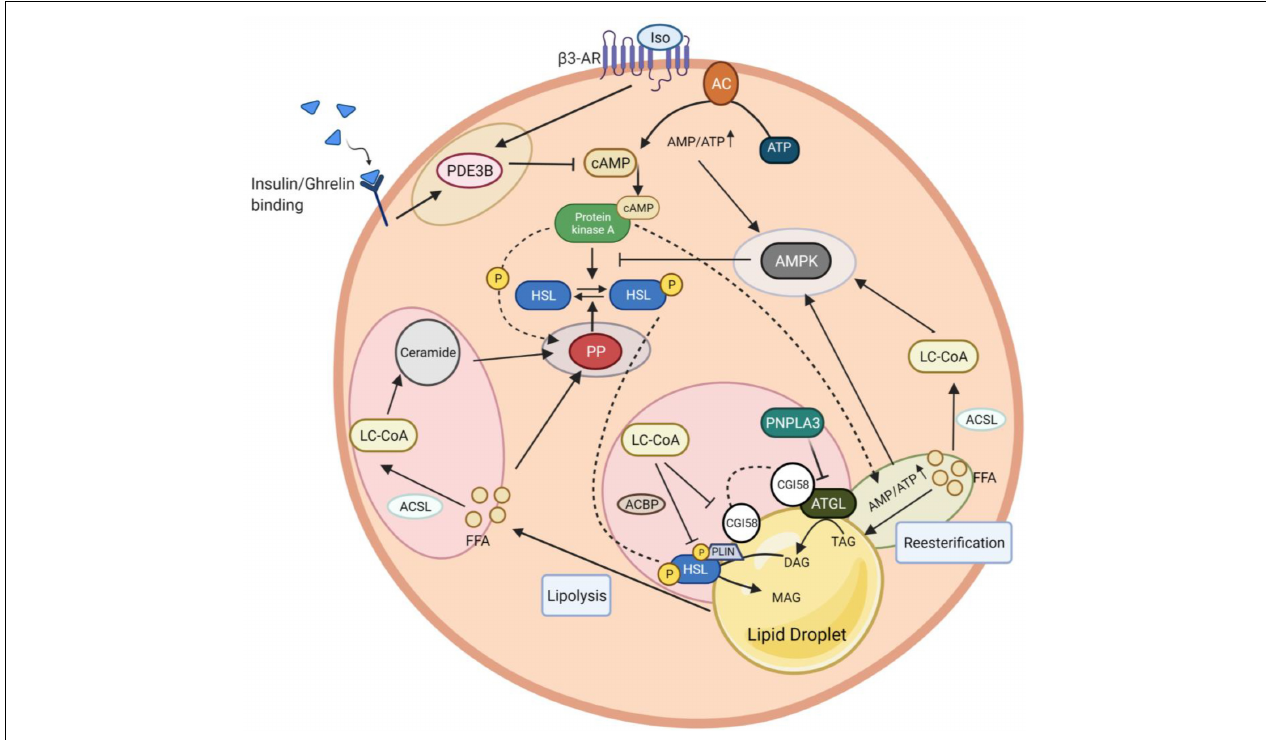
FIGURE 3 | Intracellular networks regulate adipocyte lipolysis brake. The figure illustrates five feedback mechanism loops of lipolysis marked with different colors. Insulin and isoproterenol regulate lipolysis inhibition through PDE3B-mediated cAMP degradation (yellow circle). The fine-tuning of cAMP activation involves AMPK to induce a negative feedback loop in lipolysis. AMPK stimulation is coordinated via interaction with LC-CoA, which results from ACSL-mediated FFA conversion (light blue circle). Besides LC-CoA, cAMP production and degradation together with re-esterification, participate in this AMPK induction due to an increase of the AMP/ATP ratio yielded during these processes. PKA can potentially activate a re-eseterification enzyme called DGAT (green circle). Elevated AMPK promotes a negative feedback loop of lipolysis by inhibiting PKA-mediated HSL phosphorylation. In contrast to PKA, HSL phosphorylation can be reversed by PP, whose activation highly relies on the presence of FFA and PKA to induce a feedback mechanism (purple circle). The intermediary lipid metabolite, LC-CoA, can enter the ceramide biosynthesis pathway, followed by lipolysis attenuation via PP2A activation. The dynamic regulation of endogenous LC-CoA is also shown through its impact on protein lipases (HSL, ATGL) depletion. LC-CoA acts as a non-competitive inhibitor, where it binds to CGI58 and interacts with PLIN. The LC-CoA-CGI58-PLIN complex results in the deactivation of ATGL. LC-CoA also impairs HSL function enhanced by ACBP. Similar to LC-CoA, PNPLA3 serves as a competitive inhibitor of CGI58 to attenuate the ATGL catalytic activity (pink circle). PDE3B, phosphodiesterase 3B; cAMP, cyclic adenosine monophosphate; PKA, protein kinase A; AMPK, AMP-activated protein kinase; DGAT, diglyceride acyltransferase; LC-CoA, long-chain fatty acyl–CoA esters; ACSL, long-chain-fatty-acid—CoA ligase; FFA, free fatty acid; AMP/ATP, adenosine monophosphate/adenosine triphosphate ratio; HSL, hormone-sensitive lipase; PP2A, protein phosphatase 2A; ATGL, adipose triglyceride lipase; CGI-58, comparative gene identification 58; PLIN1, perilipin 1; ACBP, acyl-CoA-binding protein; PNPLA3, patatin-like phospholipase domain-containing protein